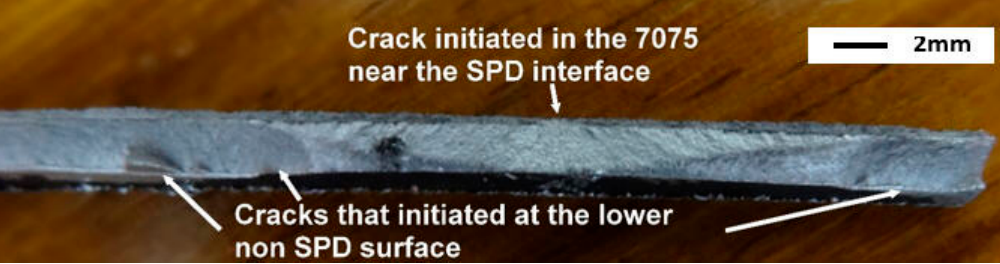
Figure 20. Multiple initiation sites both on the repaired (coated) side, in the 7075-T6 near the interface with the coating, and on the opposing face that did not have a coating.